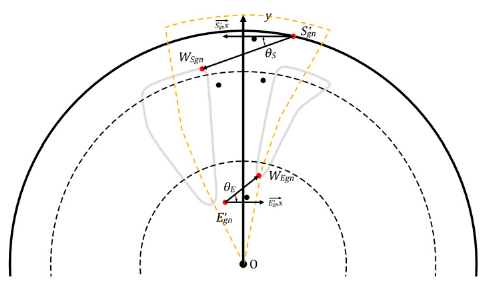
Figure 7. Radial position analysis. 𝑆 (cid:3034)(cid:3041)(cid:4593) 𝑥(cid:4652)(cid:4652)(cid:4652)(cid:4652)(cid:4652)(cid:4652)(cid:4652)(cid:4652)(cid:4652)⃗ and 𝐸 (cid:3034)(cid:3041)(cid:4593) 𝑥(cid:4652)(cid:4652)(cid:4652)(cid:4652)(cid:4652)(cid:4652)(cid:4652)(cid:4652)(cid:4652)⃗ are unit vectors. 𝑊 (cid:2903)(cid:3034)(cid:3041) is the point farthest from the center and 𝑊 (cid:2889)(cid:3034)(cid:3041) is the closest to the center. 𝜃 (cid:3020) and 𝜃 (cid:3006) are used to detect another start and endpoint. (3) Sideline analysis